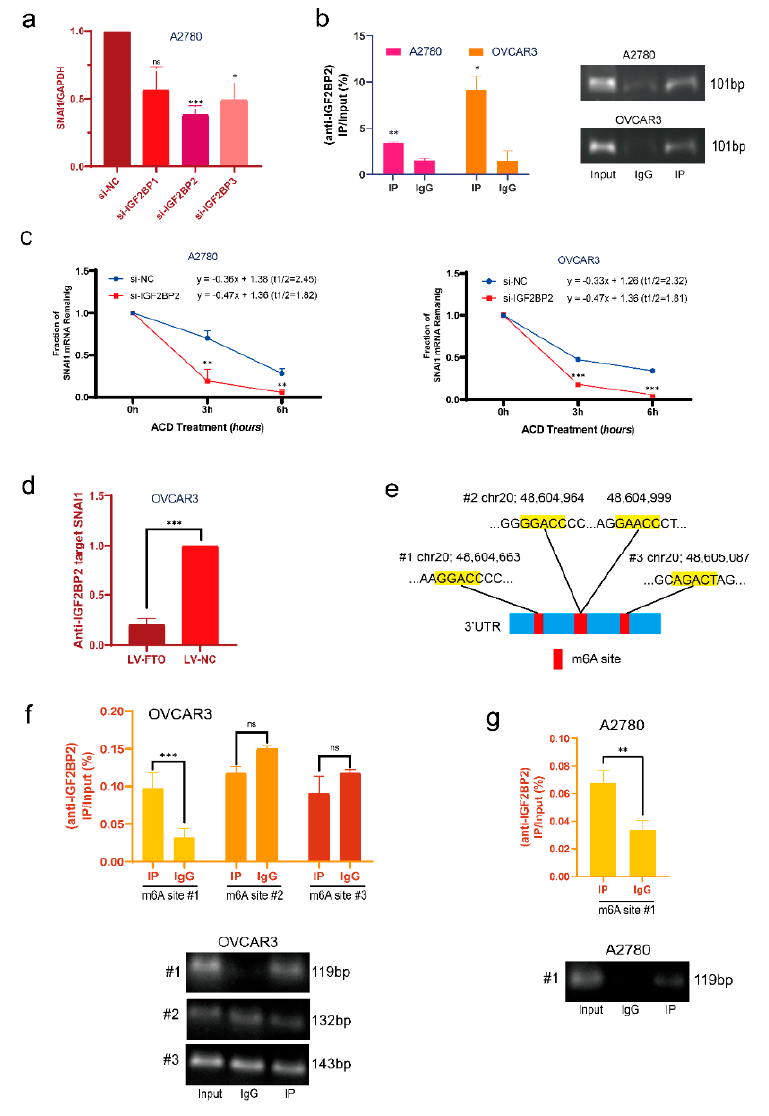
Figure 5. FTO decreases the stability and expression of SNAI1 mRNA via IGF2BP2. ( a ) SNAI1 mRNA expression in si − NC, si − IGF2BP1, si − IGF2BP2, and si − IGF2BP3 A2780 cells was examined by RT − qPCR. ( b ) Enrichment of SNAI1 mRNA interacting with IGF2BP2 was detected by RIP assay using IGF2BP2 specific antibody and IgG antibody, by RT − qPCR and DNA gel electrophoresis. ( c ) After treatment of cells with 10 µ g/mL of ACD for 0, 3, and 6 h, SNAI1 expression in si − NC or si − IGF2BP2 cells was detected by RT − qPCR. ( d ) The level of SNAI1 mRNA interaction with IGF2BP2 detected by RIP assay using IGF2BP2-specific antibody in LV − FTO or LV − NC OVCAR3 cells. ( e ) m6A site of SNAI1 3 (cid:48) UTR predicted by RMBase website. ( f ) Enrichment of SNAI1 m6A sites interacted with IGF2BP2 in OVCAR3 cells detected by RIP assay and by RT − qPCR. ( g ) Enrichment of SNAI1 m6A sites 1 interacted with IGF2BP2 in A2780 cells detected by RIP assay and by RT-qPCR. The data represent the results of three independent replicates. Data are presented as mean ± SD; ns, not significant; * p < 0.05; ** p < 0.01; *** p < 0.001. The uncropped blots are shown in Supplementary Material file S1